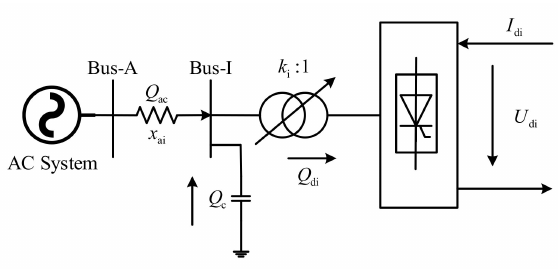
Figure 4. Equivalent model of the inverter